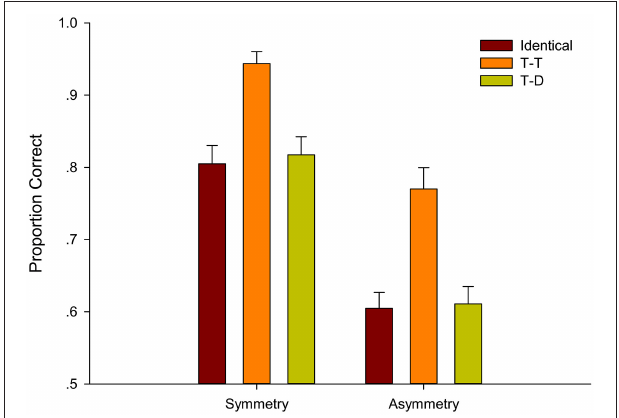
FIGURE 9 | Average proportion correct and standard error for six conditions classified by groupings based on symmetry and shape in Experiment